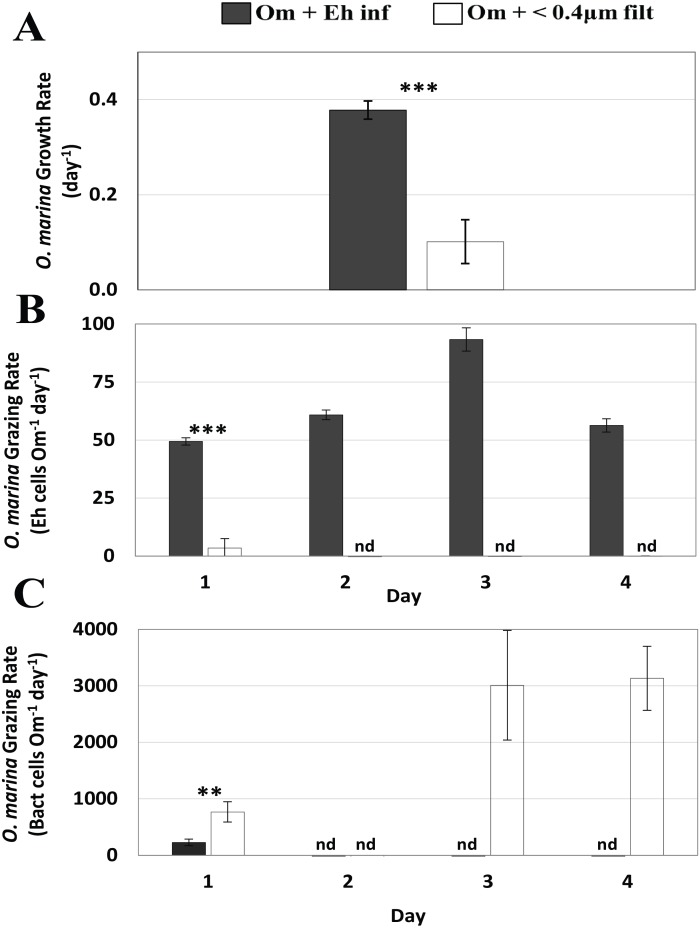
Differential growth and grazing rates measured in experiment 5 for O. marina fed non-axenic infected E. huxleyi versus <0.4 µm filtrate of a non-axenic infected E. huxleyi culture.(A) O. marina growth rates (day−1). (B) O. marina grazing of E. huxleyi cells (Eh cells Om−1 day −1). (C) O. marina grazing of bacteria cells (Bact cells Om−1 day−1). Values mean ± one standard deviation. nd denotes “none detected”. Asterisks indicate statistical significance: ***p < 0.001, **p < 0.01.